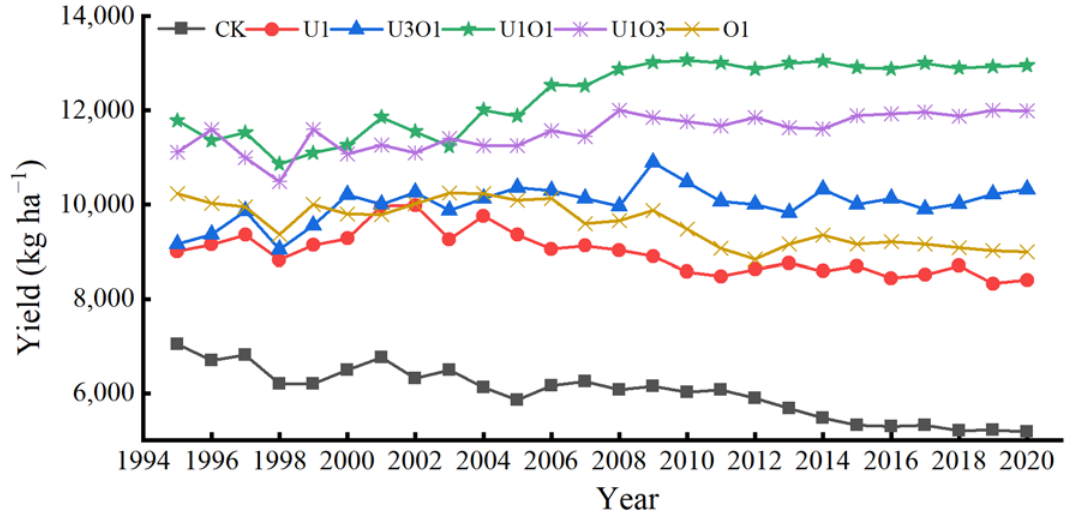
Figure 6. DNDC model of the dynamics of maize yield under different treatments.